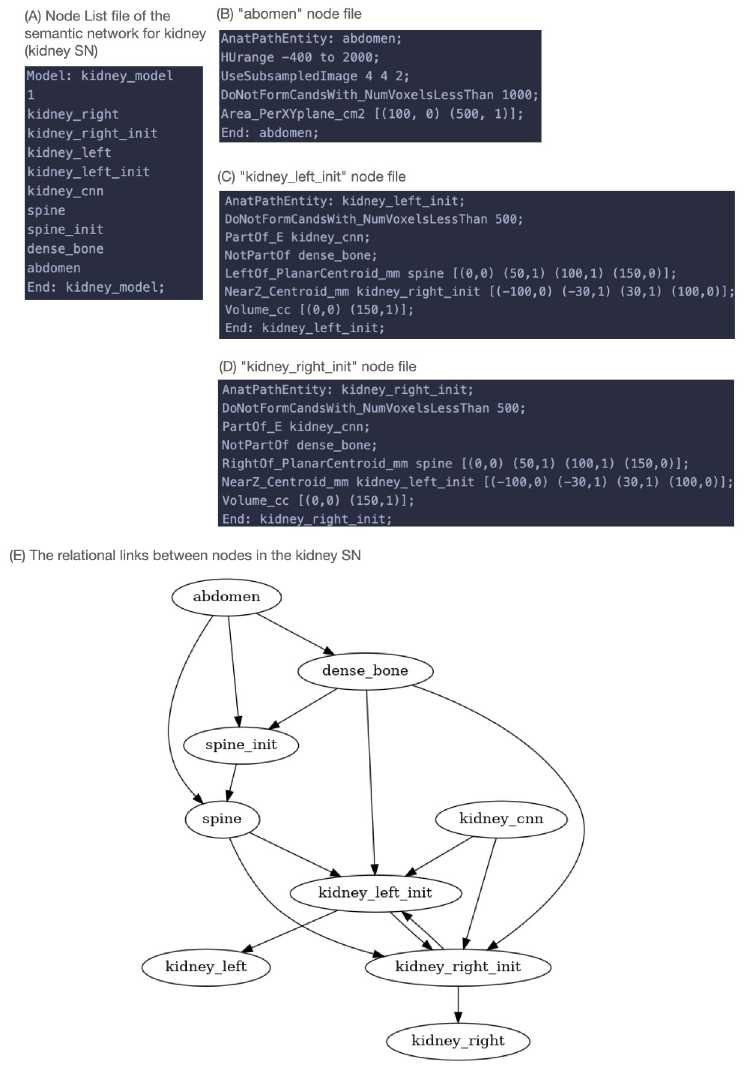
Fig 2. SimpleMind semantic network (SN) for kidney segmentation. The human readable text files of the SimpleMind semantic network (SN) for kidney segmentation. (A) The “Node List” text file of the SN where each line corresponds to a node in the SN. (B) The text file for the thorax node, containing the attributes for recognizing the thorax object. (C) The text file for the kidney_left_init node. (D) The text file for the kidney_right_init . (E) Graph visualization of the kidney